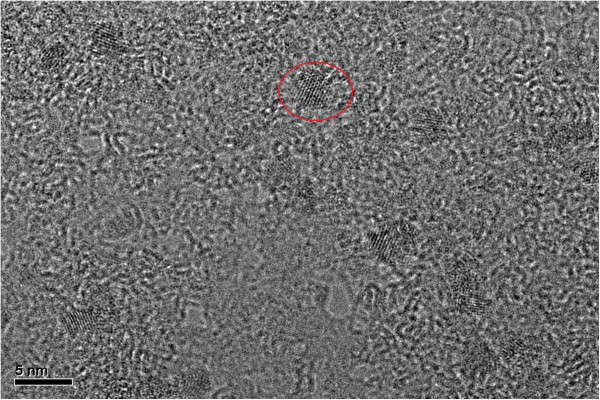
TEM of CdTe, λem = 554 nm.